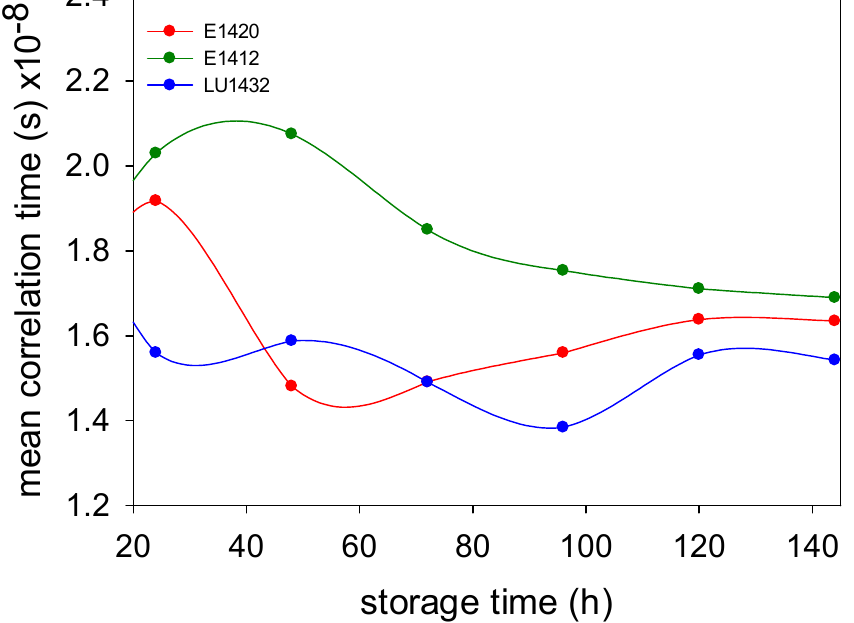
Figure 4. Time-dependent changes in mean values of proton motion correlation times of fat proton fraction in porcine fat emulsions.